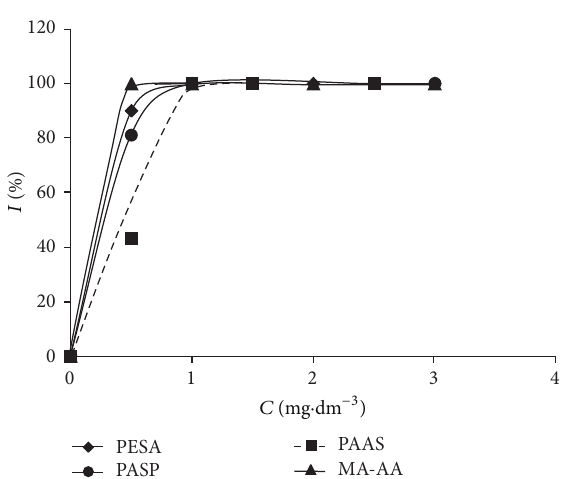
Figure 1: Inhibition of calcium sulfate precipitation in the presence of varying concentration ( C ) of inhibitor after 24 hours